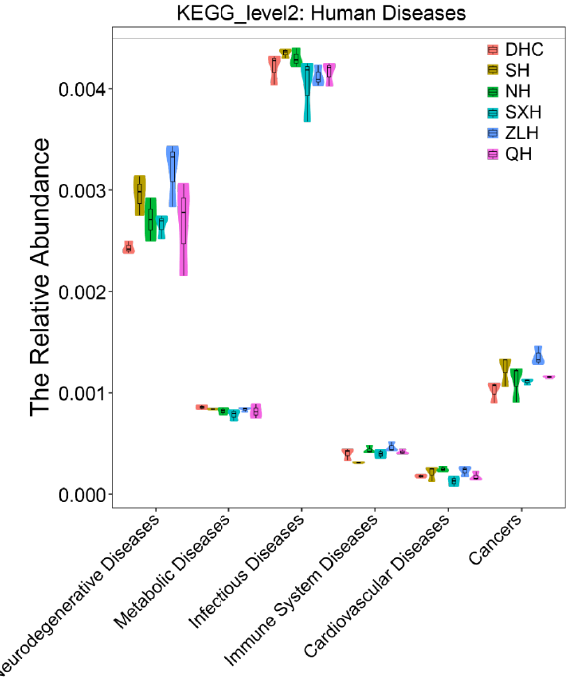
Table A1. Species list of zooplankton in six sampling sub-lakes.